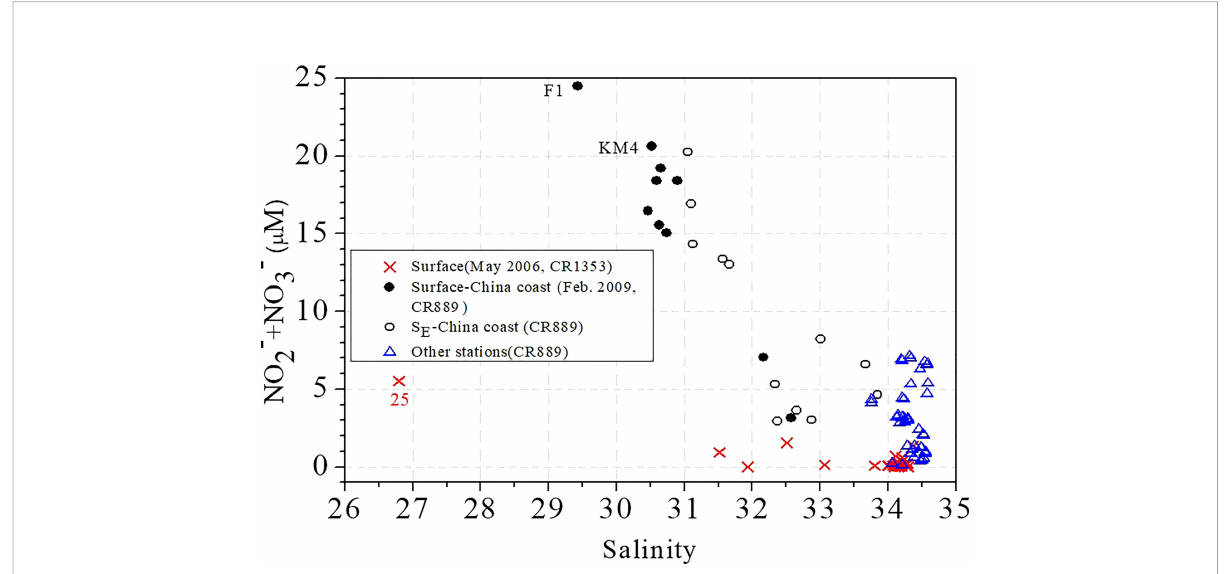
FIGURE 9 Schematic plot of N+N concentrations and salinity in early summer ( × , CR1353) and winter (other icons, CR889) in the TS. S E -China coast is surface- excluded samples in the coast of China. The sampling stations with particularly low salinity and high N+N concentrations (25, F1, KM4) are